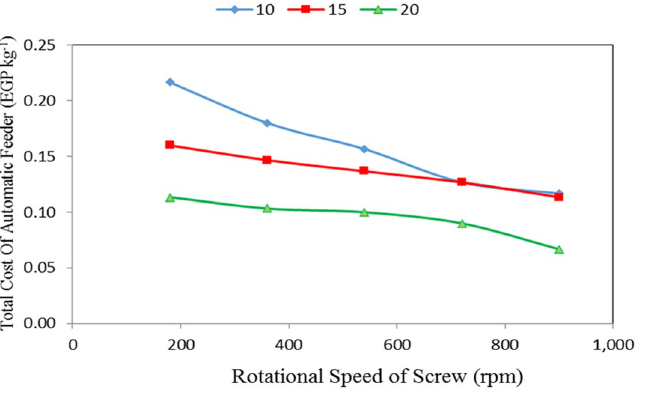
Figure 15. Total cost of automatic feeder at different rotational speeds of screw and air flow